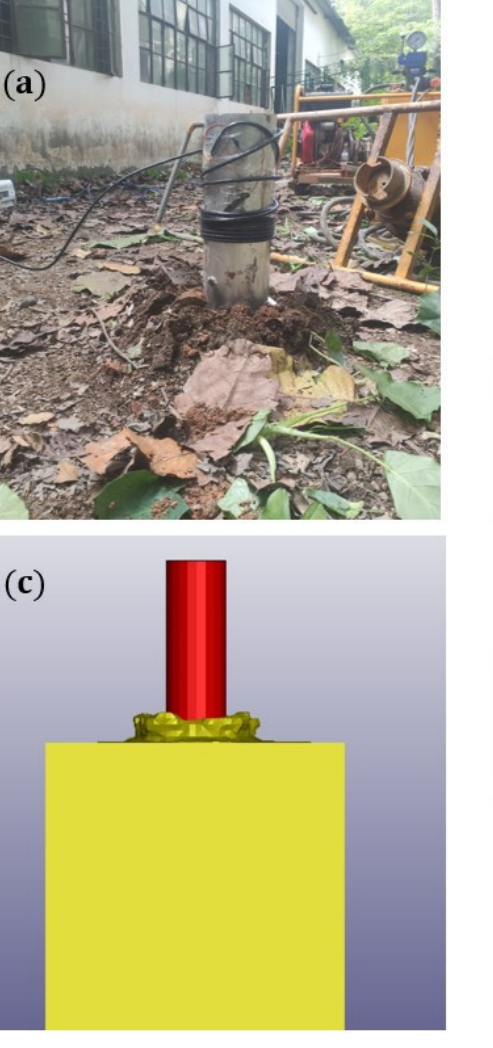
Figure 10. Comparison of the soil deformation between numerical simulation and field test: ( a ) field test; ( b ) FEM-SPH; ( c , d ) FEM.